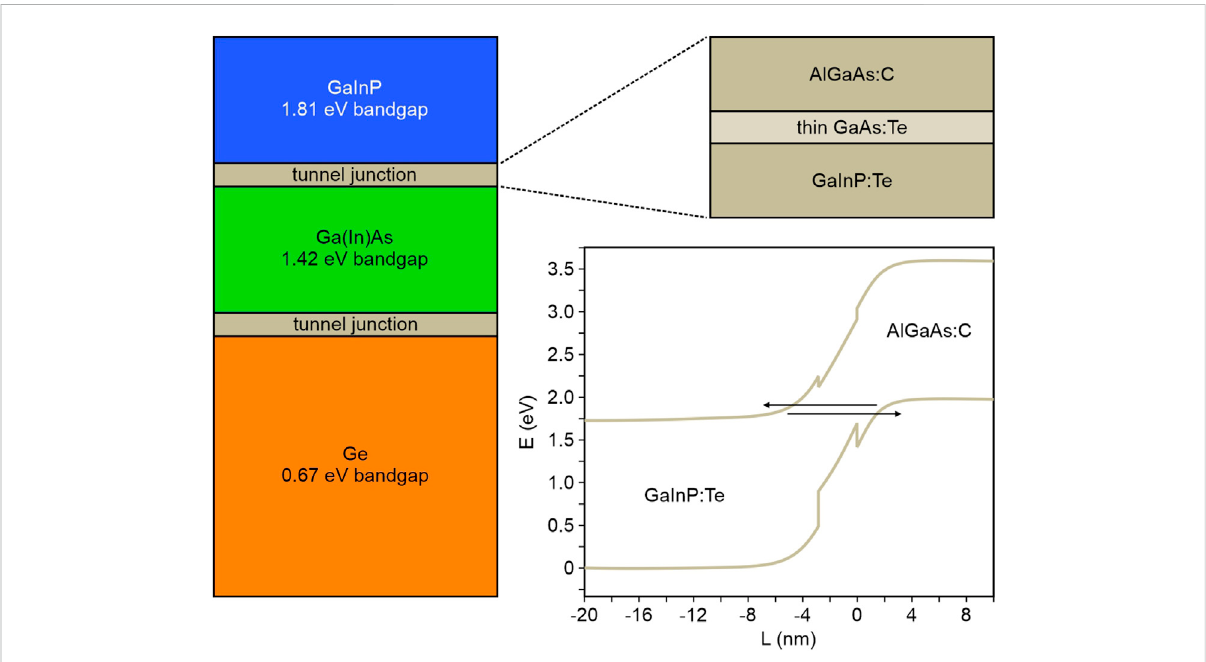
FIGURE 2 Energy bandgaps of absorber layers in 3-J solar cell and a zoom in on a tunnelling junction and its calculated band diagram. Images adapted from (Colter, Hagar and Bedair,